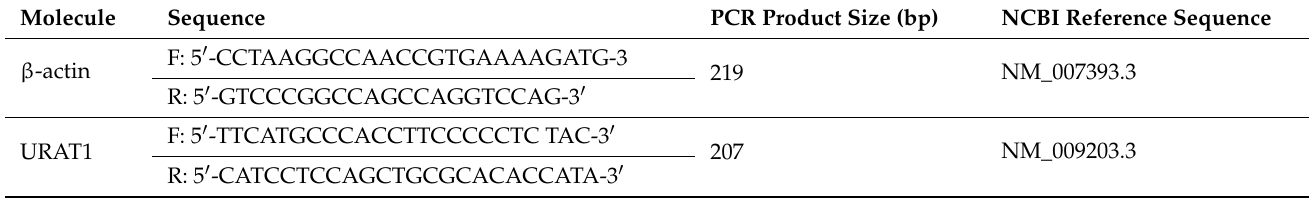
Table 5. Primers used to determine the expression of URAT1 using qualitative